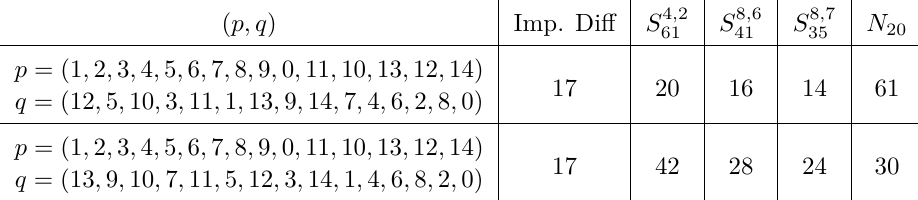
Table 5: Security evaluation for the best equivalence classes with k = 15 ( p, q ) Imp. Diff S 4 , 2